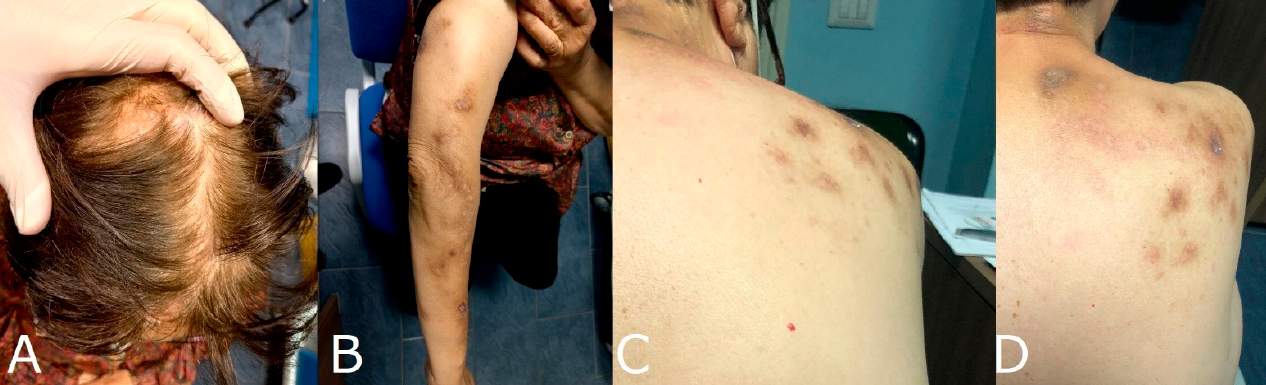
Figure 3. Multiple hyperkeratotic nodules on the right side of the head ( A ), the right upper limb ( B ), and the right upper trunk ( C , D ) after 16 weeks of dupilumab treatment; a reduction in inflammation and the number/thickness of lesions may be seen.